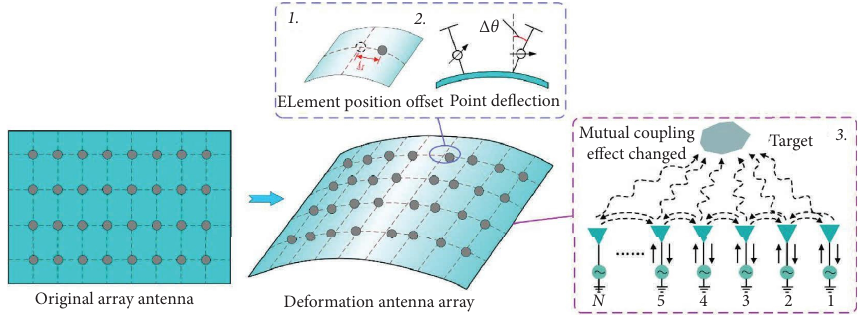
Figure 7: Structural-electromagnetic-thermal coupling relationship of